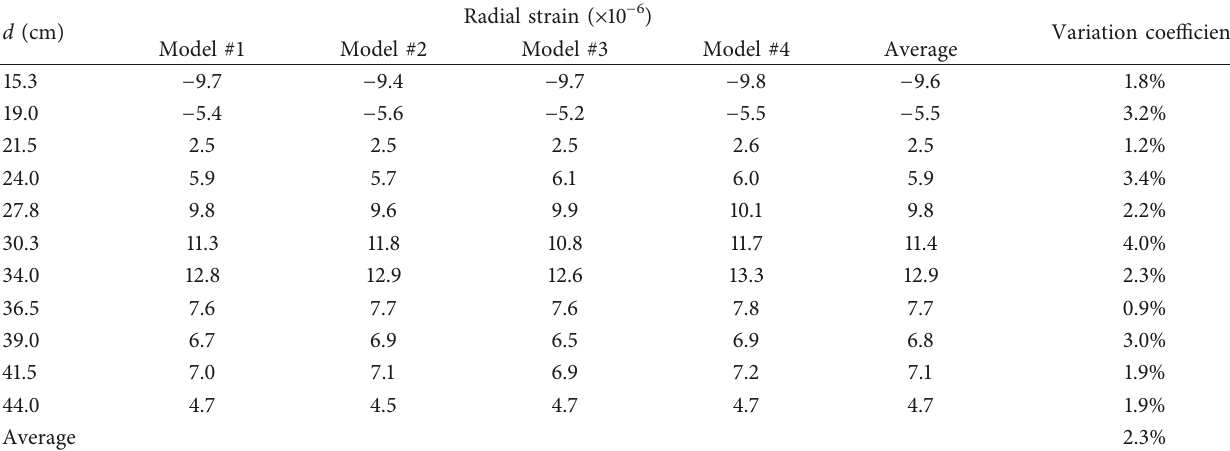
Table 6: Parallel test results of radial strain of the AC pavement structure model. d (cm)